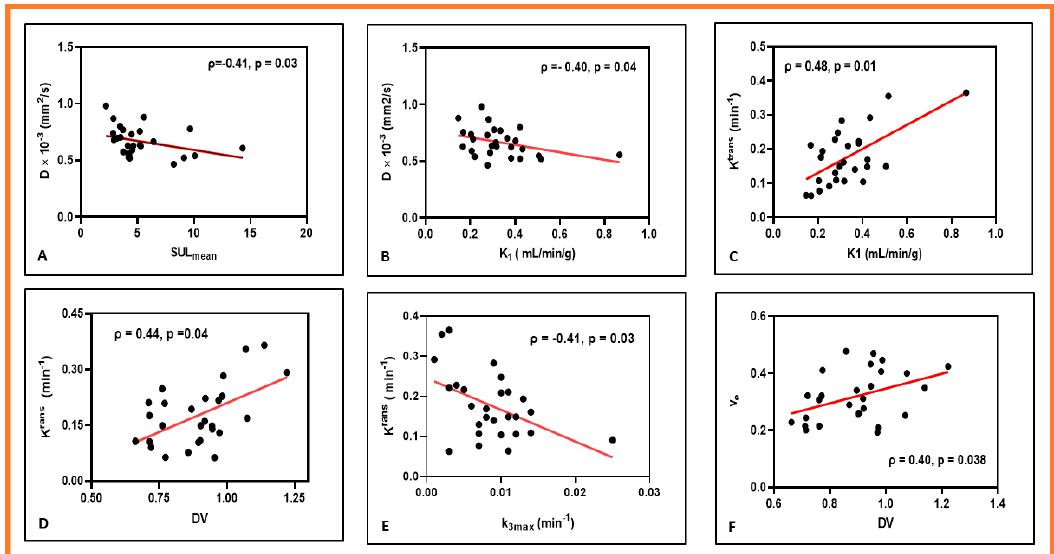
Figure 6. Representative scatter plots showing the relationships between quantitative imaging metrics derived from multimodality imaging methods. ( A ) True diffusion coefficient ( D ) vs. mean of the maximum standardized uptake value normalized to lean body mass (SULmean). ( B ) D vs. K 1 (Perfusion constant for FMISO). ( C ) K trans (Volume transfer constant for Gd-based contrast agent) vs. K 1 . ( D ) K trans vs. DV (FMISO distribution volume). ( E ) K trans vs. k 3max . ( F ) v e (Volume fraction of the extravascular extracellular space ) vs. DV.